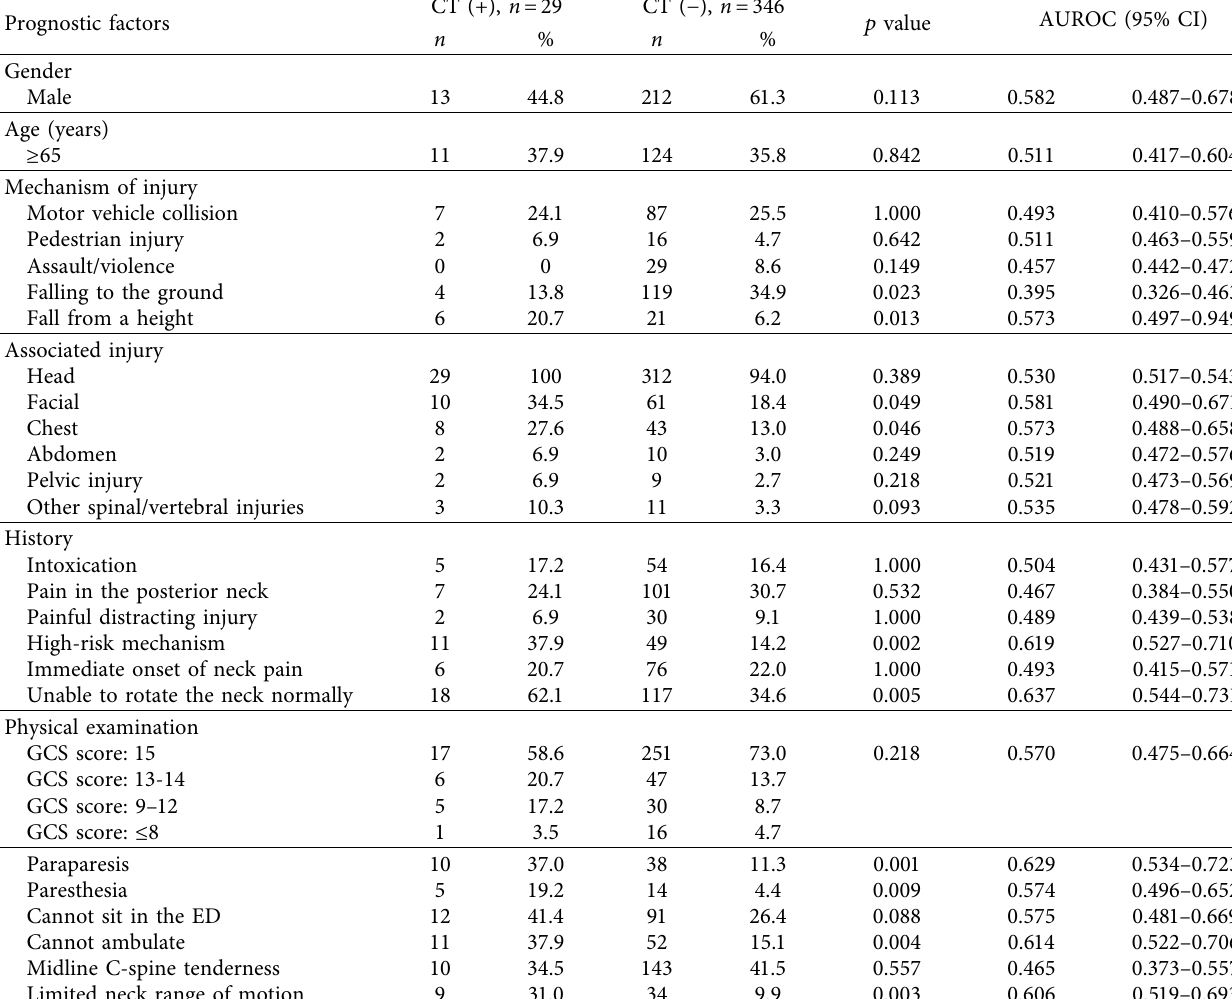
Table 1: Clinical prognostic factors of CT (+) versus CT ( − ), p value, AUROC, and 95% CI.